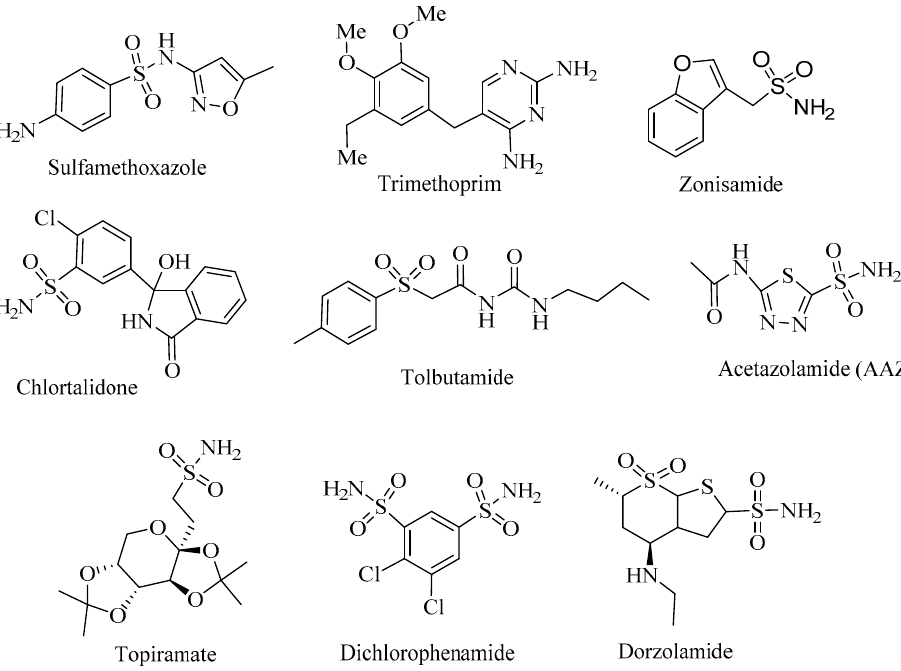
Figure 1. The structure of approved sulfonamide drugs.